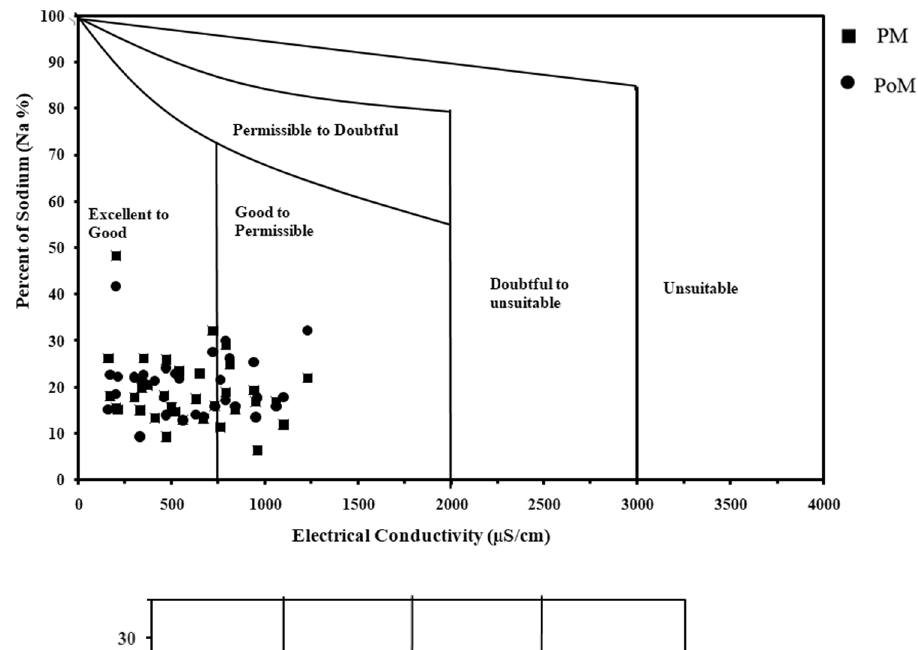
Fig. 9 The USSL Salinity Hazards diagram for Classifica- tion of irrigation water based on Sodium (SAR) and Salinity (EC) hazards during both PM and PoM